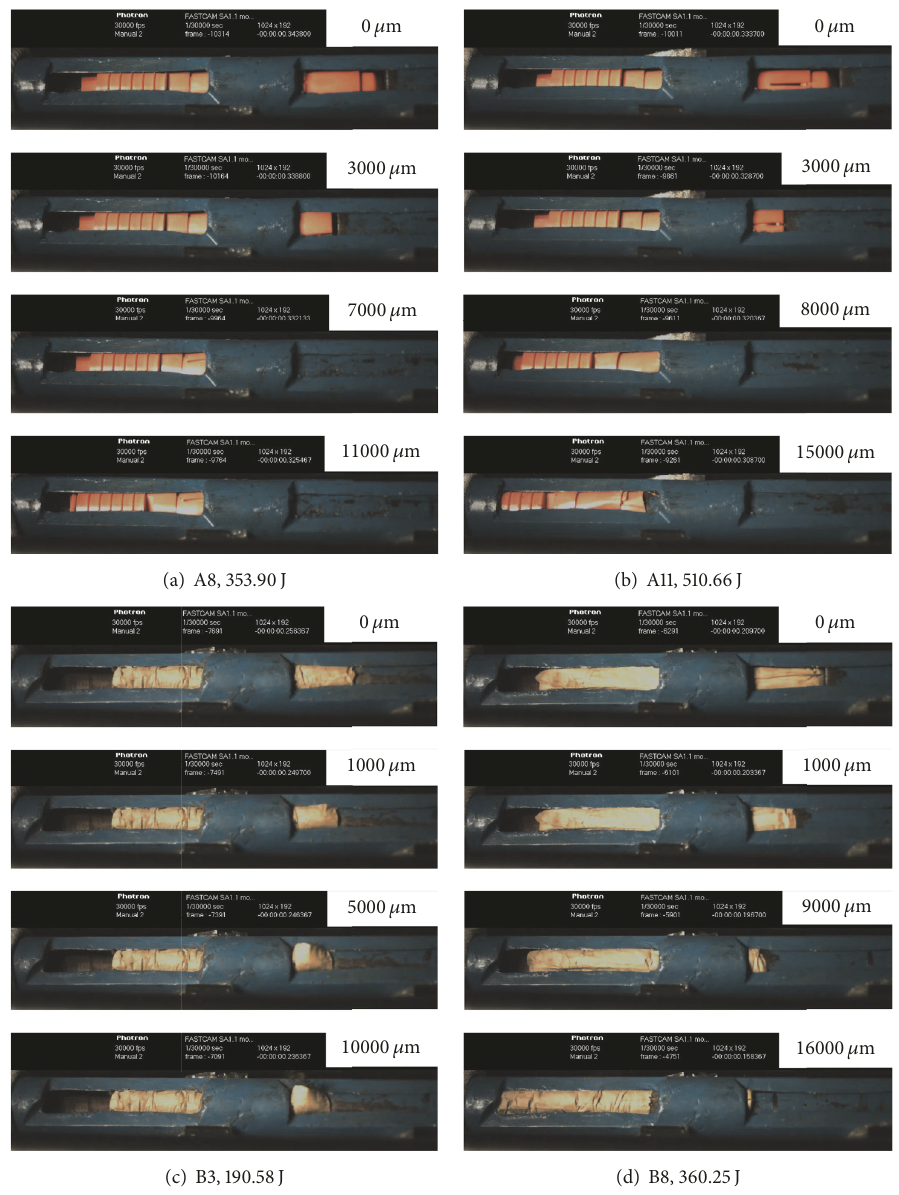
Figure 9: Impact failure process of typical samples at different test times.